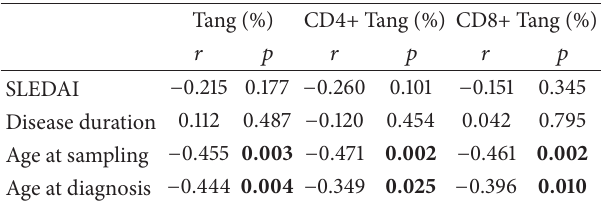
Table 2: Correlations between the percentages of Tang cell subsets and SLEDAI, disease duration, age at sampling, or age at diagnosis in SLE